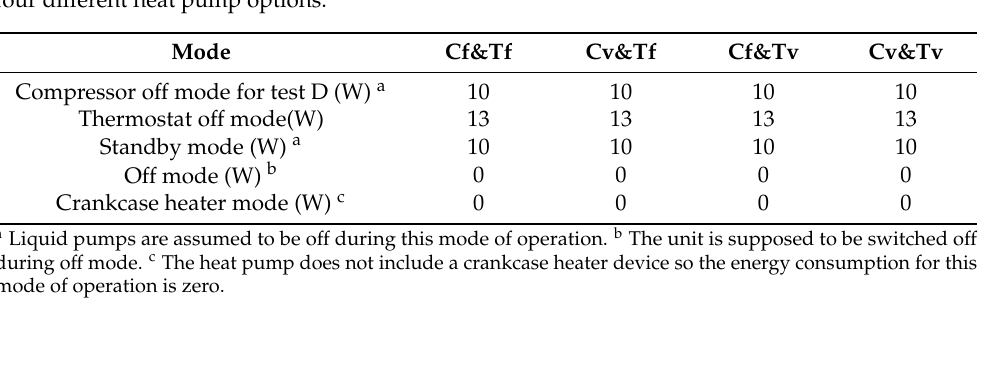
Table 3. Experimental values of power consumption during modes other than active mode for the four different heat pump options.